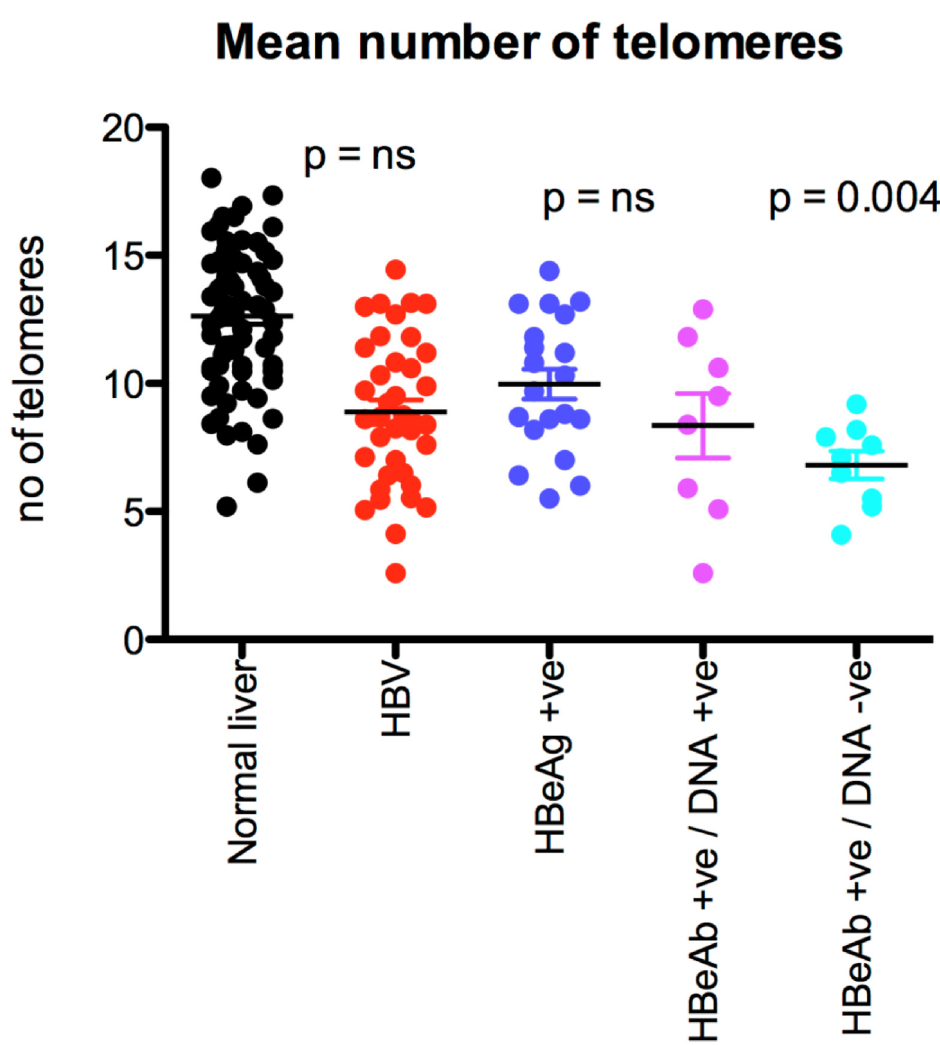
Fig 3. The mean number of telomeres in normal and HBV-infected liver tissue according to viral load.